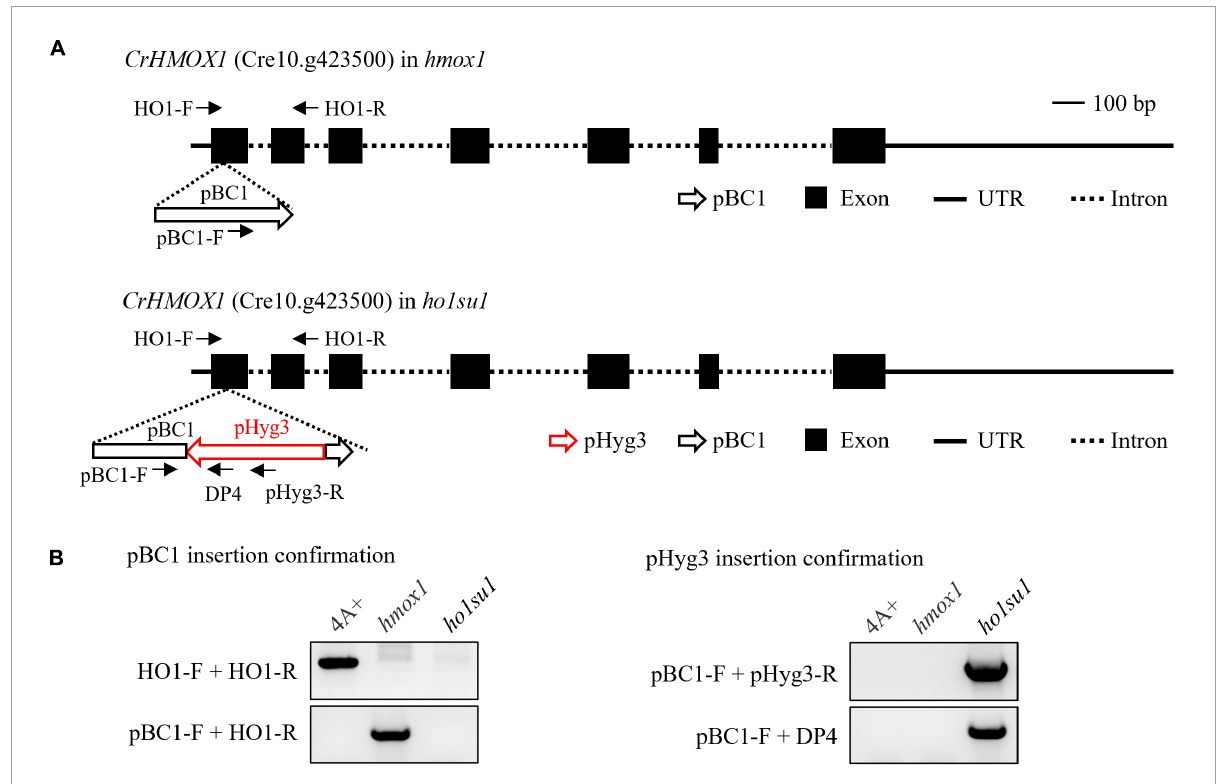
FIGURE3 Identification of the pHyg3 insertion site in ho1su1 . (A) Schematic diagram of the paromomycin resistance gene cassette (pBC1) and the hygromycin resistance gene cassette (pHyg3) insertion sites in hmox1 (upper) and ho1su1 (lower). The arrows represent primers used for plasmid insert analysis. (B) Analysis of pBC1 and pHyg3 insertion sites in hmox1 and ho1su1 using PCR and primers depicted in (A)